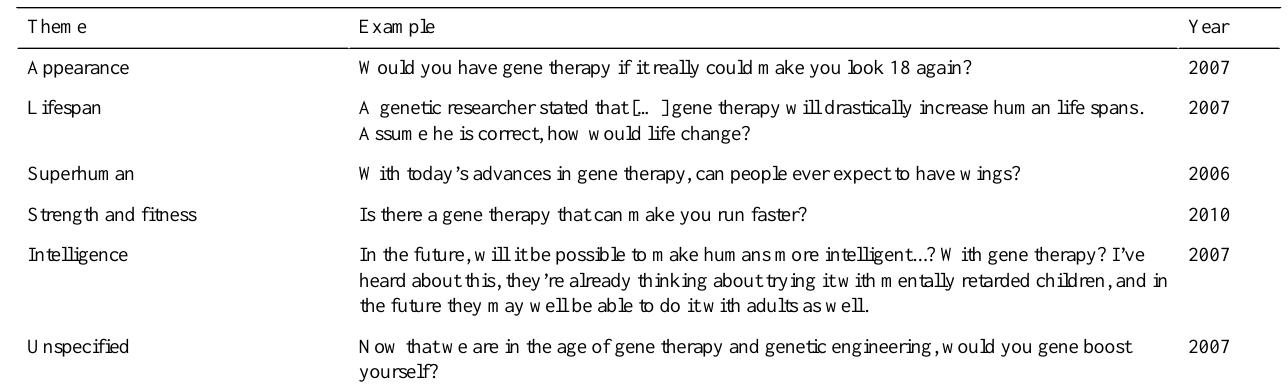
Table 3. Examples of types of enhancement.